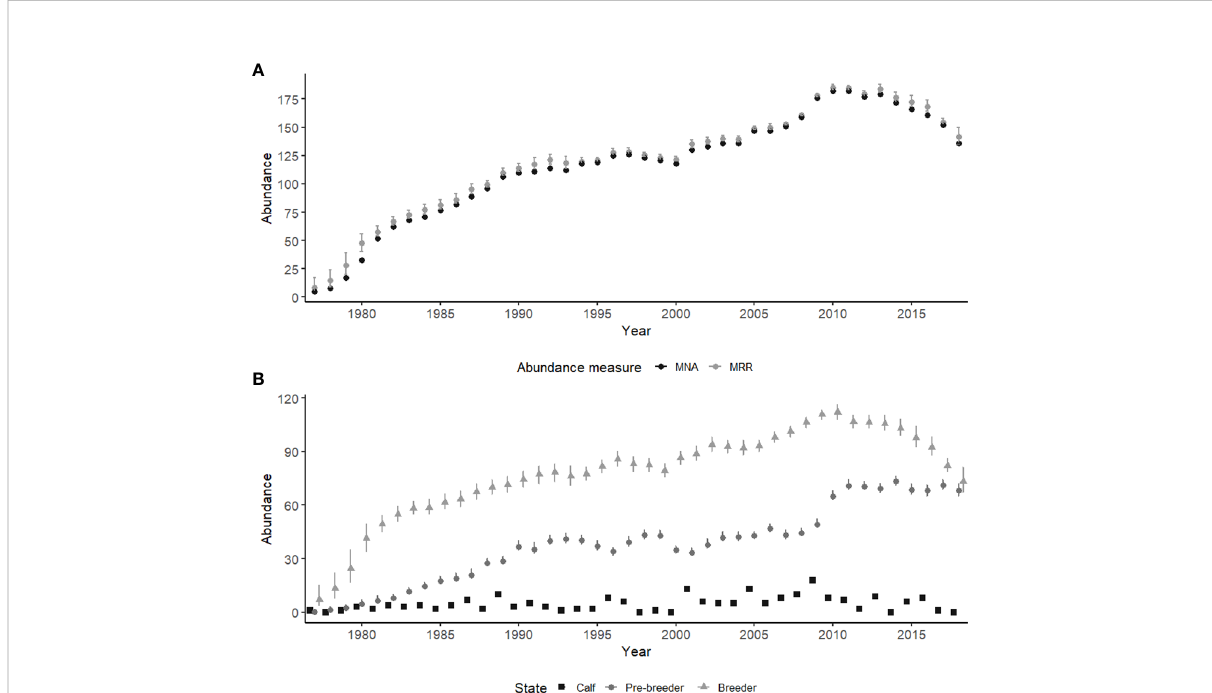
FIGURE 2 Abundance estimates for female North Atlantic right whales from 1977-2018. (A) Abundance estimates for female North Atlantic right whales, mark-recapture-recovery (MRR) model estimates (grey), compared to minimum number alive (MNA) for each year (black). (B) The breakdown of abundance into state with calf (squares), pre-breeders (circles) and breeders (triangles). Error bars indicate the 95% credible intervals. Calf abundance was derived from counts of female calves sighted yearly, and are not